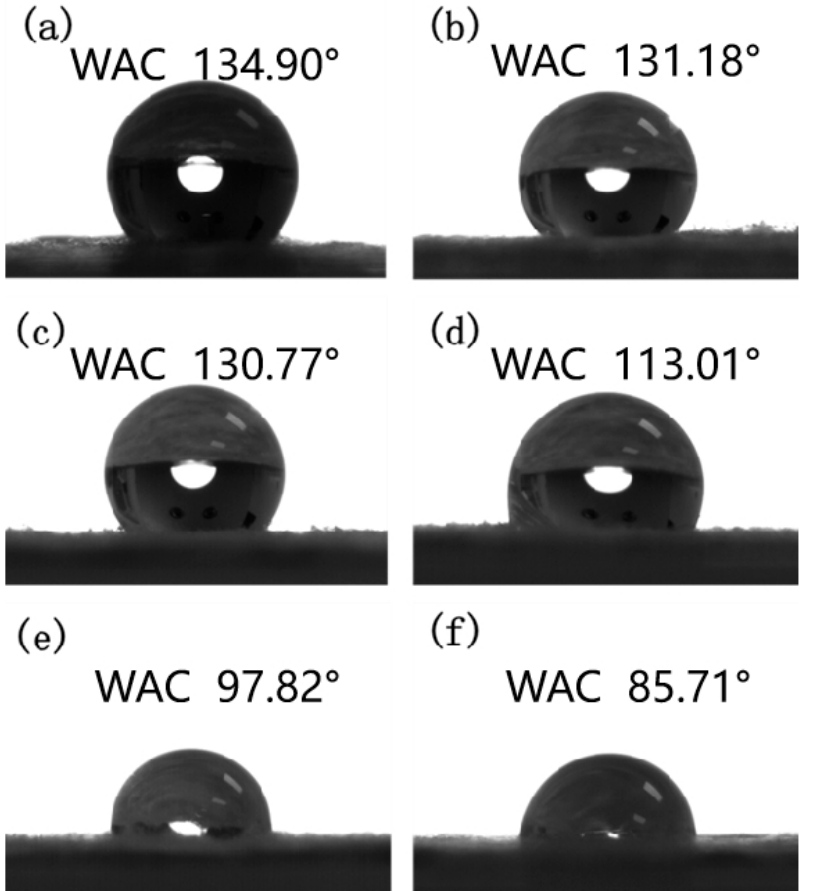
Figure 8. Water contact angle of di ff erent fi ber membranes: ( a ) PLA, ( b ) PLA/CDA (9/1), ( c ) PLA/CDA (8/2), ( d ) PLA/CDA (7/3), ( e ) PLA/CDA (6/4), ( f ) CDA.